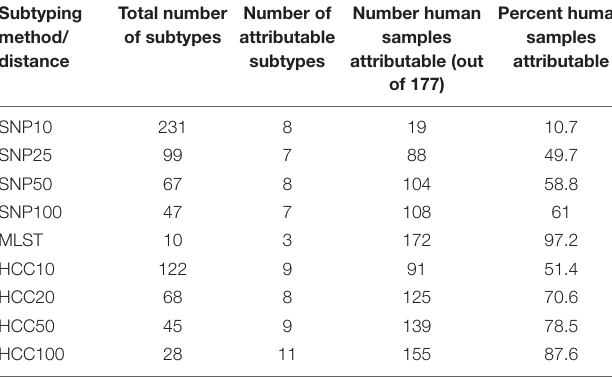
TABLE 3 | Number of subtypes and animal samples of the same subtype as a human isolate for subtyping by SNP distance (SNP), 7 loci MLST, and hierarchical clustering (HCC) of core-genome MLST data.